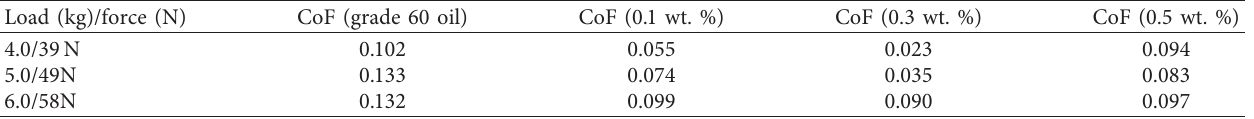
Table 3: Coefficient of friction values of NPDP with different wt. % of ZnO ball-milled nanoparticles at various loads for 1hour duration.